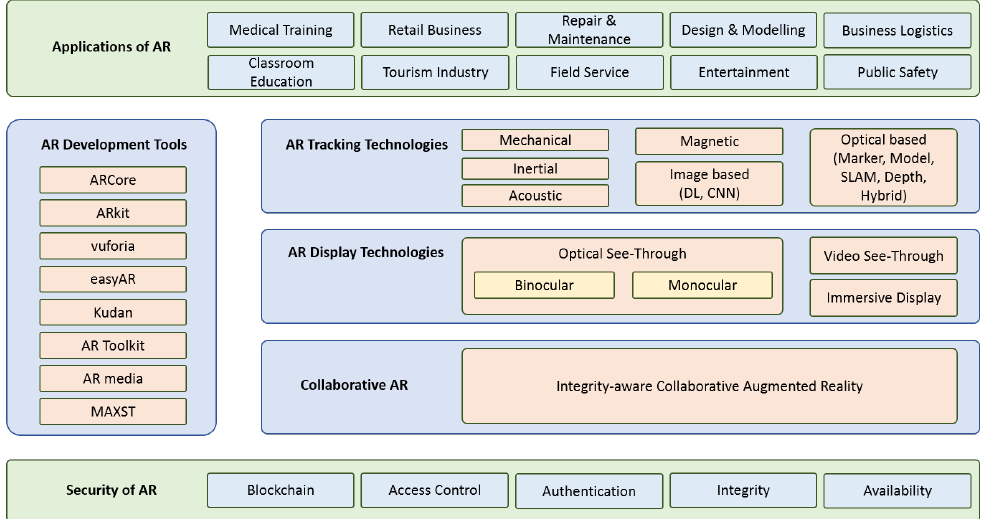
Figure 1. Overview of AR, VR and Collaborative AR applications, tools, and